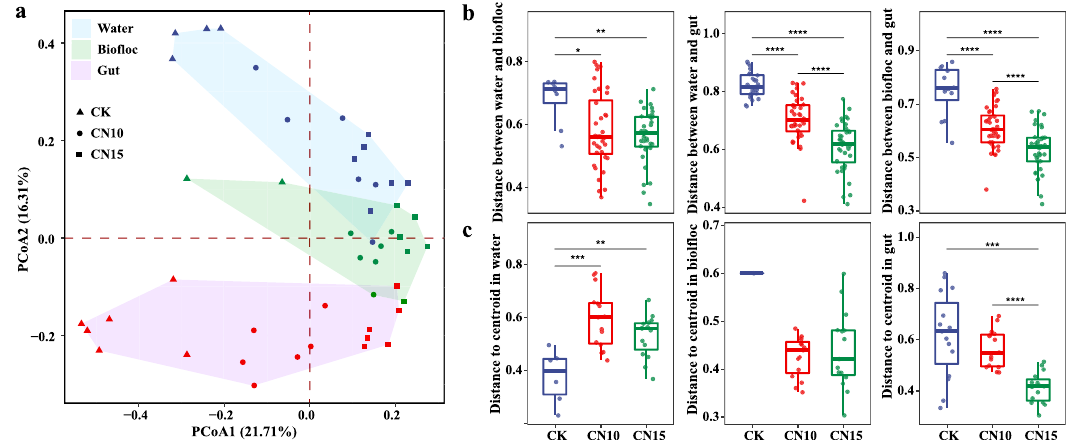
Fig. 1 Effects of sucrose addition on the bacterial community structure of rearing water, bio fl oc and gut in the shrimp culture systems. a Principal coordinate analysis (PCoA) plot based on the Bray-Curtis dissimilarity shows the dissimilarities of bacterial community between control and sucrose addition groups in rearing water, bio fl oc, and gut samples. b The pairwise dissimilarities of bacterial community of rearing water, bio fl oc and gut in control and sucrose addition culture systems. c The dissimilarities of bacterial communities within group of rearing water, bio fl oc and gut samples in control and sucrose addition culture systems. CK: without sucrose addition; CN10: the C/N ratio of about 10:1 obtained by sucrose addition; CN15: the C/N ratio of about 15:1 obtained by sucrose addition. Each sample had six replicates ( n = 6), except the water samples ( n = 4) and bio fl oc samples ( n = 2) in control group. The boxes represent the median and interquartile range, and whiskers range from minimum to maximum values. Different asterisks indicate a signi fi cant difference at * p < 0.05, ** p < 0.01, *** p < 0.001 and **** p < 0.0001 in ( b ) and ( c ) based on Student ’ s t